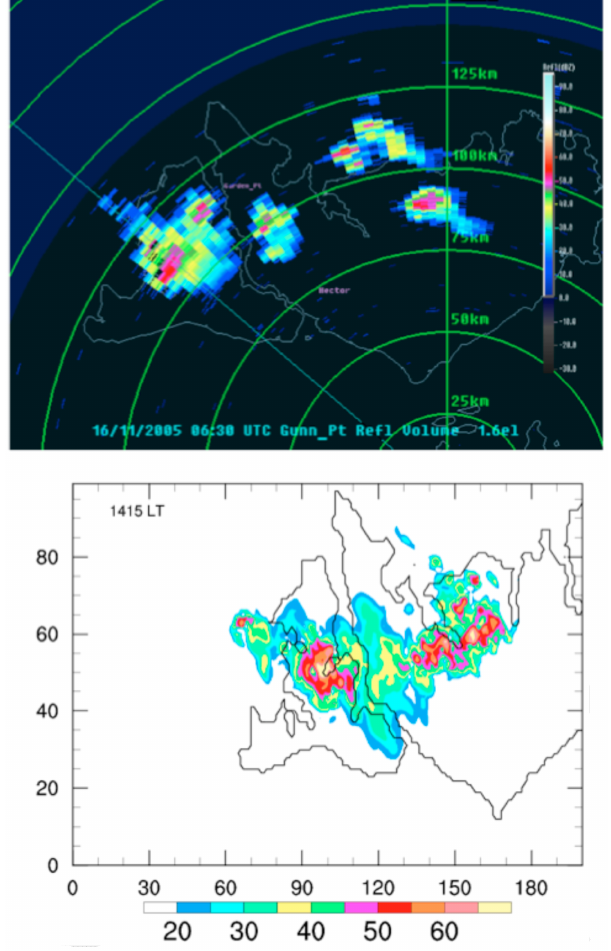
Fig. 7. Comparison of observed radar reflectivity at 16:00LT (top, from Vaughan et al., 2008) to modeled 2.5km reflectivity at 14:15LT (bottom). Note the radar echo intensity (dBZ) in the ob- served radar reflectivity (top) is contoured at every 10dBZ with the red/magenta interface approximating 50dBZ. The x- and y-axes in the bottom figure show distance in km.